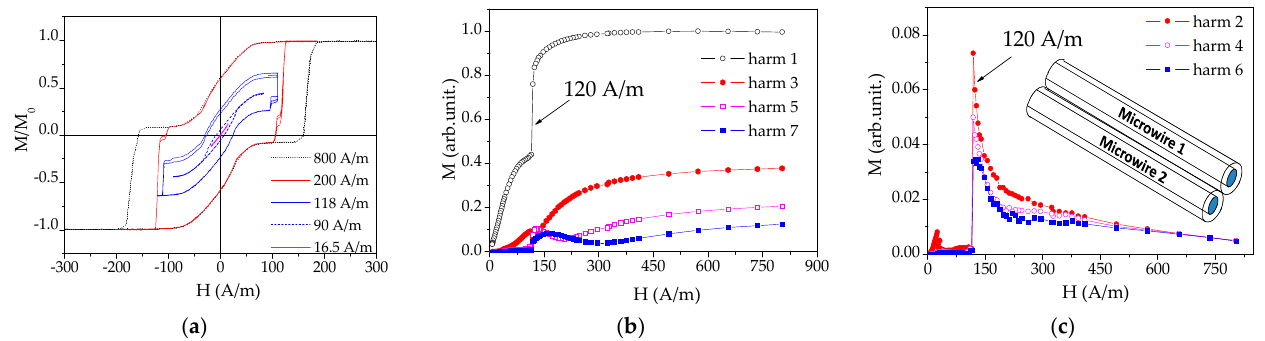
( b ) Figure 6. Dependences of odd harmonics ( a ) and even harmonics ( b ) on magnetic field amplitude in Fe 74 B 13 Si 11 C 2 microwires ( d = 19.4 μ m). Reprinted with permission from [51]. A sharp increase in the harmonics amplitudes is observed when H 0 exceeds H s1 and H s2 (see Figure 6a,b). The even harmonics amplitudes are significantly inferior to the odd harmonics amplitudes. The field dependences of odd harmonics have a “plateau” be- tween 60 and 90 A/m, which reflects the hysteresis loops splitting (see Figure 6a). Another example of tuning the nonlinearity of hysteresis loops and harmonics is the magnetostatic interaction of microwires with different character of hysteresis loops. Ra- ther nonlinear hysteresis loops can be obtained in an array consisting of one Fe 74 B 13 Si 11 C 2 and one Co 67 Fe 3.9 Ni 1.5 B 11.5 Si 14.5 Mo 1.6 microwire (see Figure 7a). In such array, at H 0 < 90